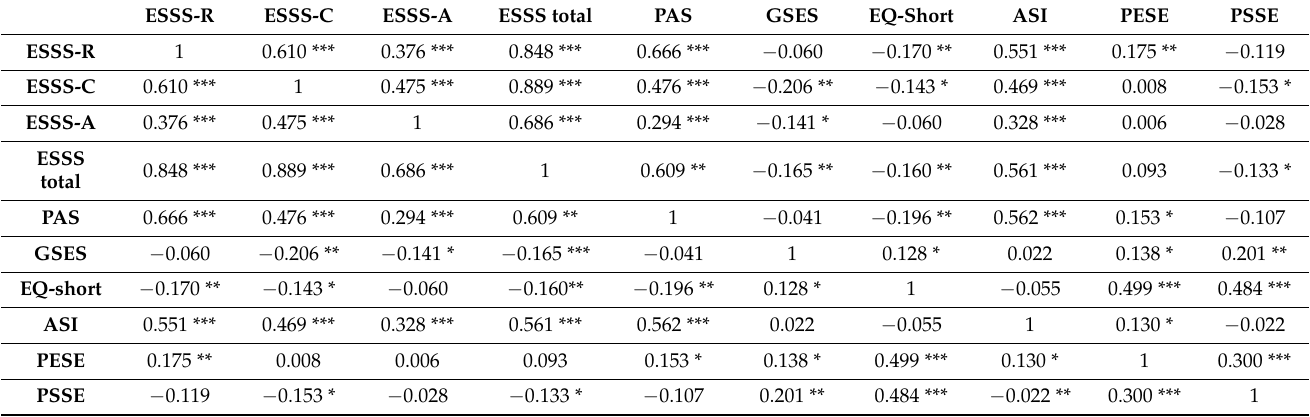
Table 5. Pearson’s correlation coefficients between the psychometric indices in the